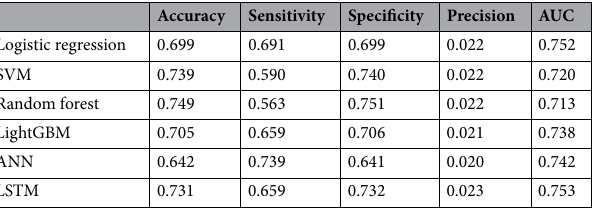
Table 3. Comparison of the different machine learning models. The choice of machine learning model did not have a critical impact on the results.